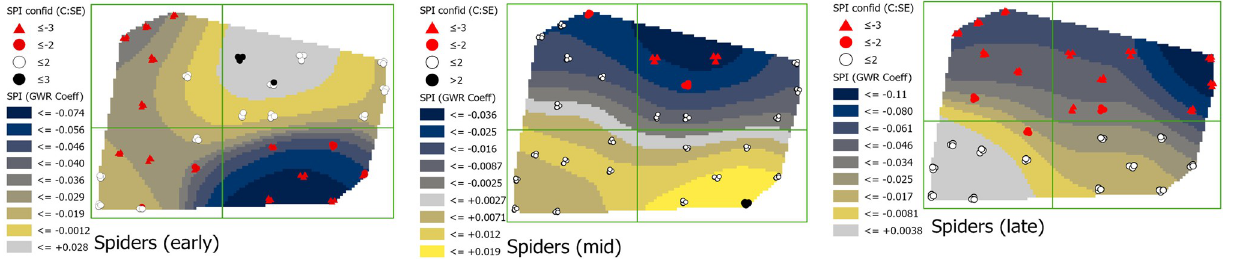
Fig 11. Maps showing early, mid-, and late season spiders (SPI_TOT_1) coefficients with estimations of credence in coefficient values. Coefficient surface values were symbolized using a geometric interval classification scheme from blue to gold, with grey indicating the interval including zero (if